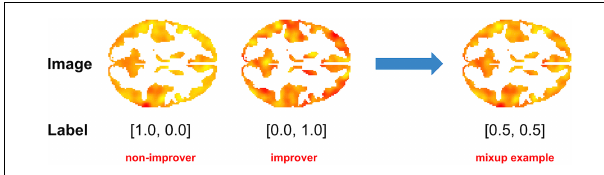
FIGURE 2 | Example of Mixup as applied to fMRI data. In this example, a 50/50 virtual instance was created by combining task (cognitive control-associated) fMRI data from a recent onset patient with schizophrenia with a good clinical outcome [ > 20% Improvement in Total Brief Psychiatric Rating score after 1 year of treatment (“Improver”)] with that of a patient with a poor clinical outcome (“Non-Improver”). Data were taken from a study by Smucny et al.